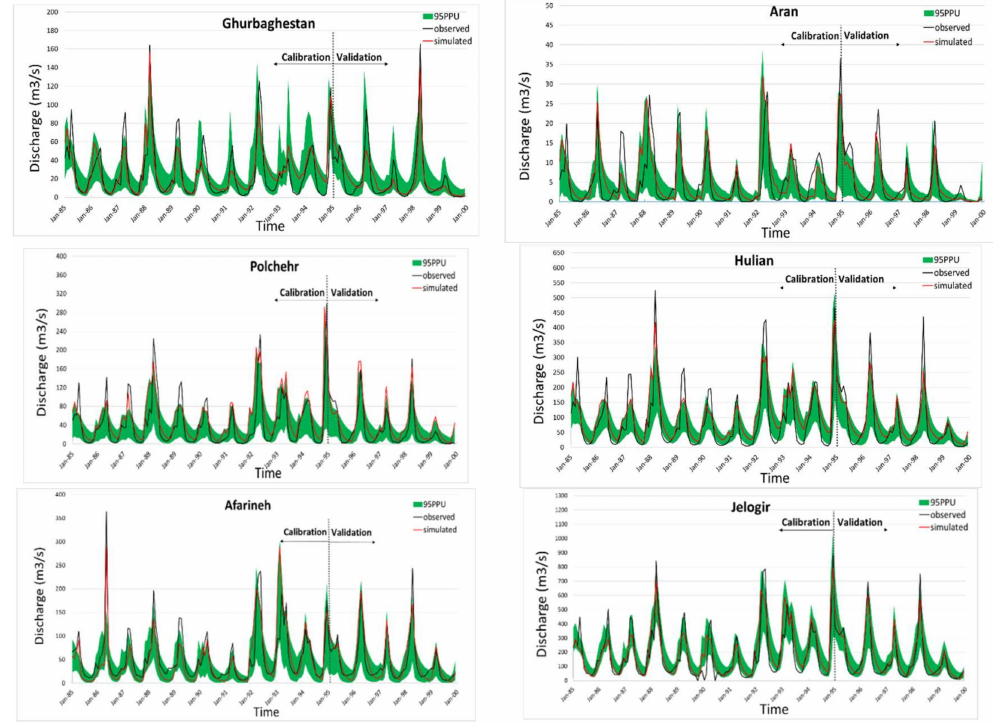
Figure 3. Monthly SWAT calibration/validation of river discharge